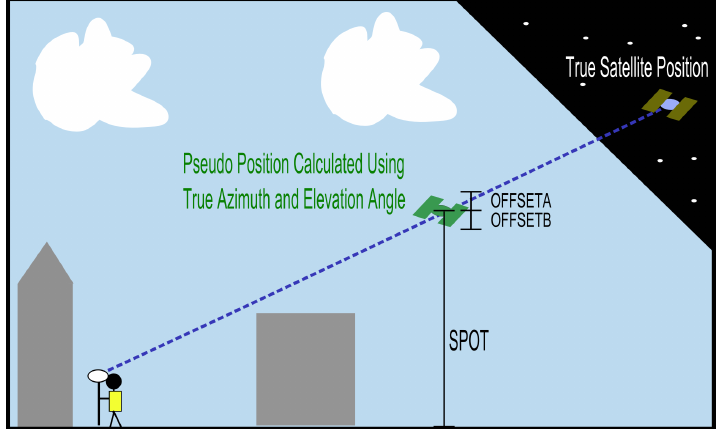
Figure 8. Creating a viewshed observer point using the pseudo satellite